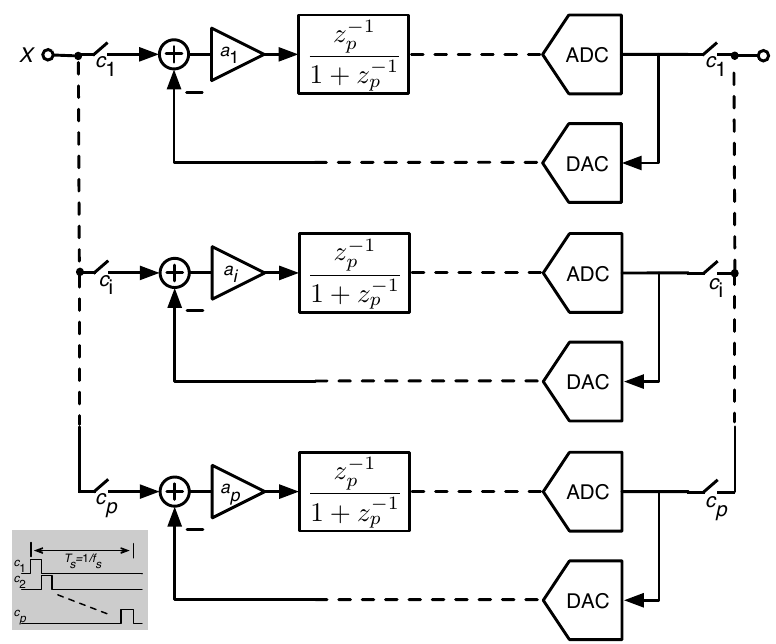
Figure 8. Conceptual block diagram of a TI BP- Σ∆